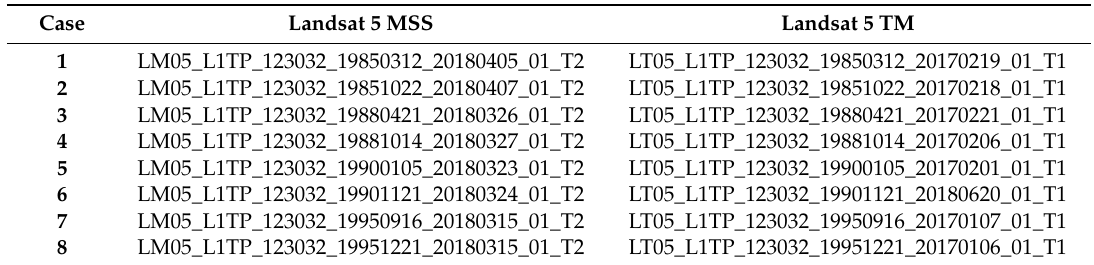
Table 2. Archived pairs of Landsat 5 MSS and TM observations used for case applications 1